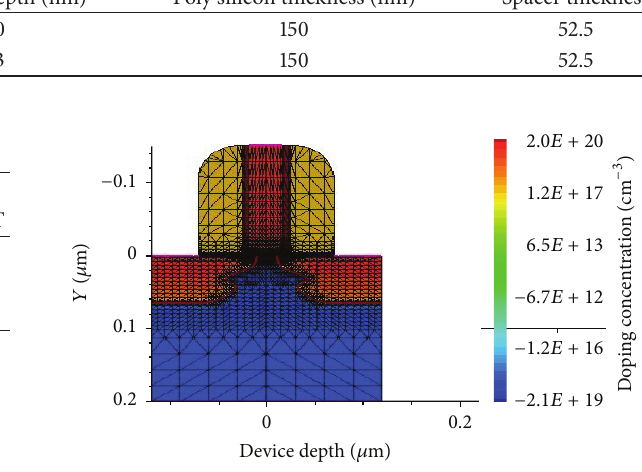
Figure 2: Simulation structure of 45 nm